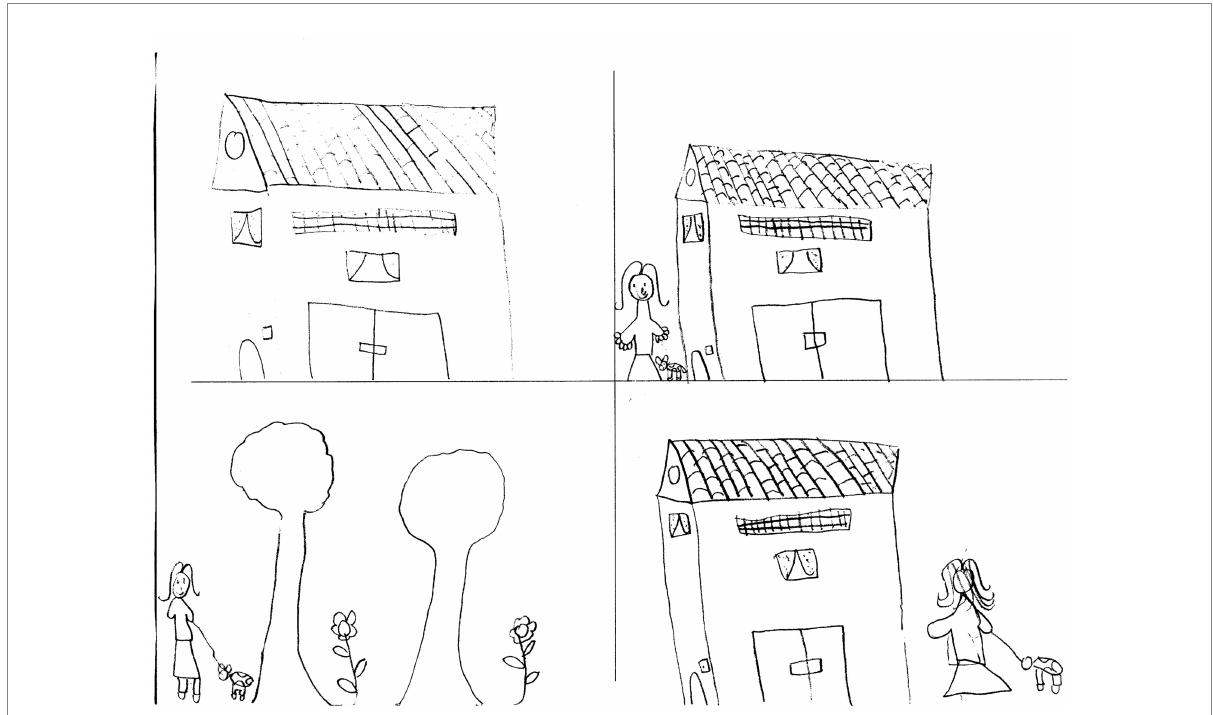
FIGURE 1 Drawn Stories Technique. Positive outcome (PO) example: “ There is a girl in the house. Then, she goes out to walk the dog. Finally, she returns to the house and she is happy about that beautiful walk. ” Female, 8 years